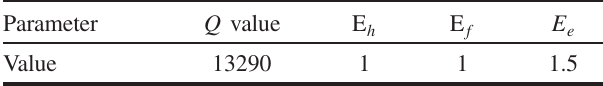
TABLE I. Design parameters of ECC-rf gun cavity.